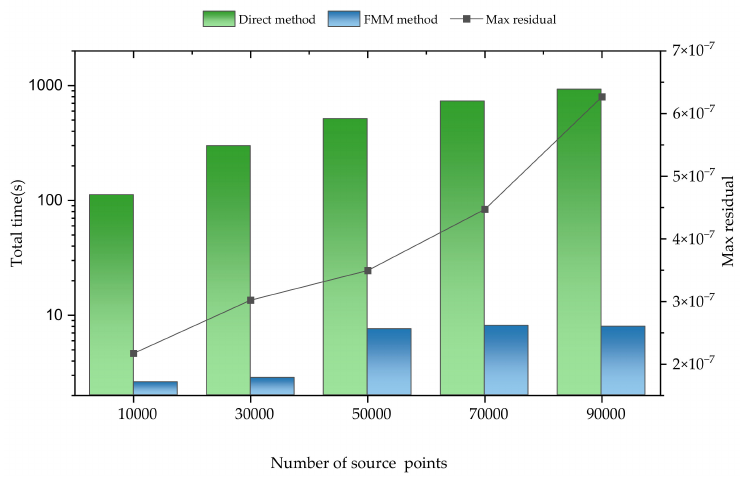
Figure 5. Comparison of the fast evaluation method and the direct evaluation method with different interpolation points (when the number of evaluation points is